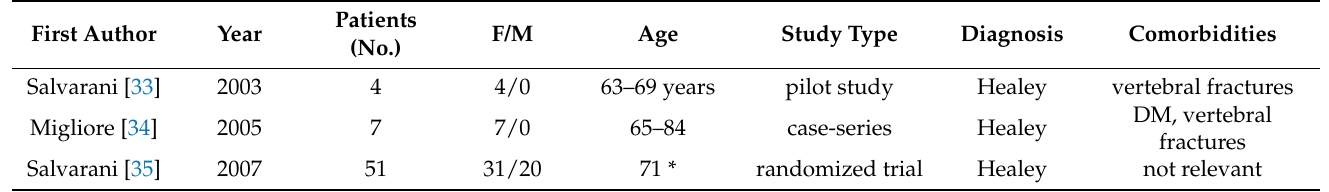
Table 1. Infliximab in patients with PMR. Main features of the three discussed studies.